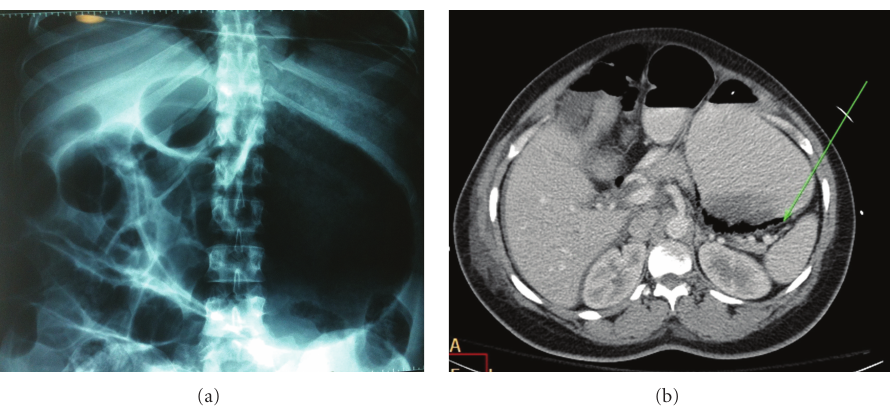
Figure 1: Plain film of abdomen and CT abdomen showing gastric dilatation of stomach and emphysema (arrow).